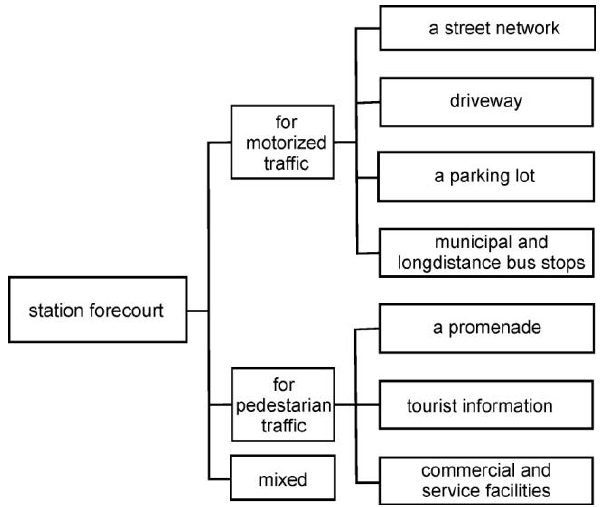
Fig. 2. Development of railway station surrounding